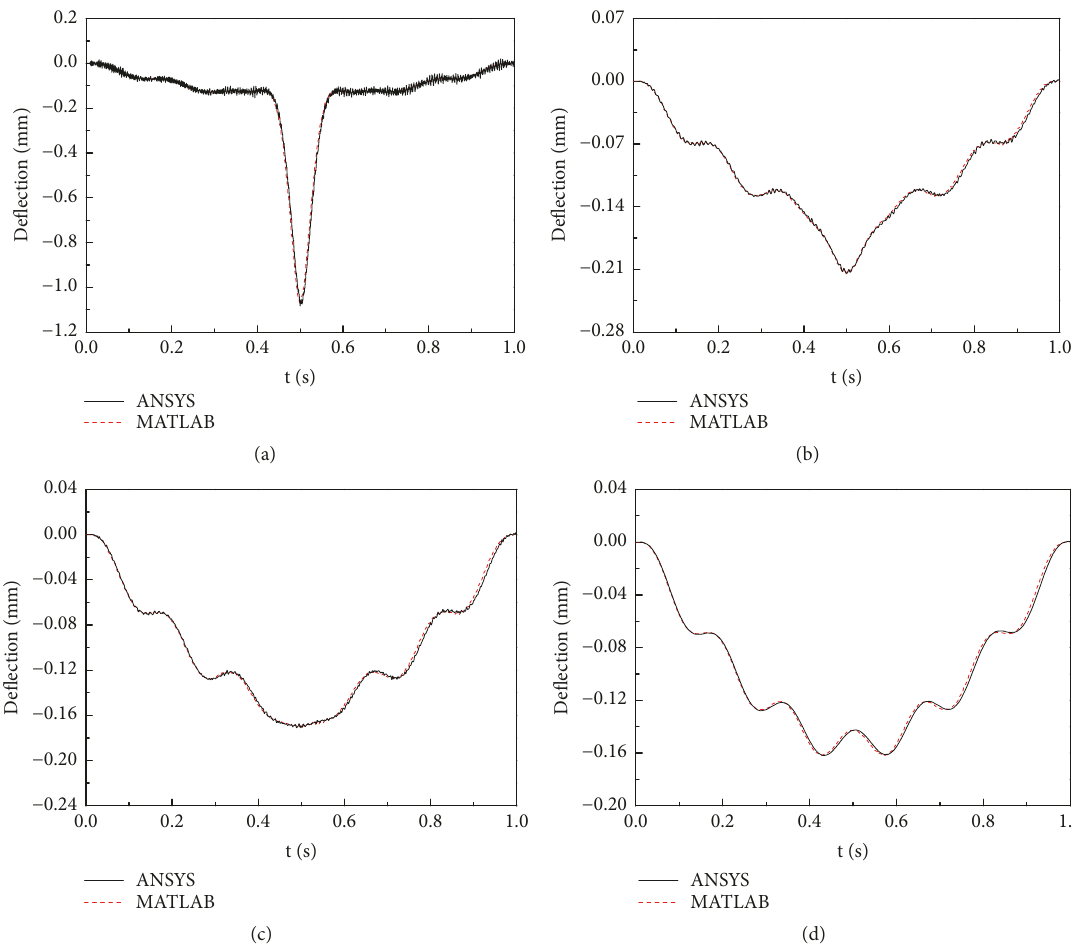
Figure 5: Mid-span deflection time-history for quadruple simply supported beam system with load moving speed v = 32 m/s: (a) first beam; (b) second beam; (c) third beam; (d) fourth